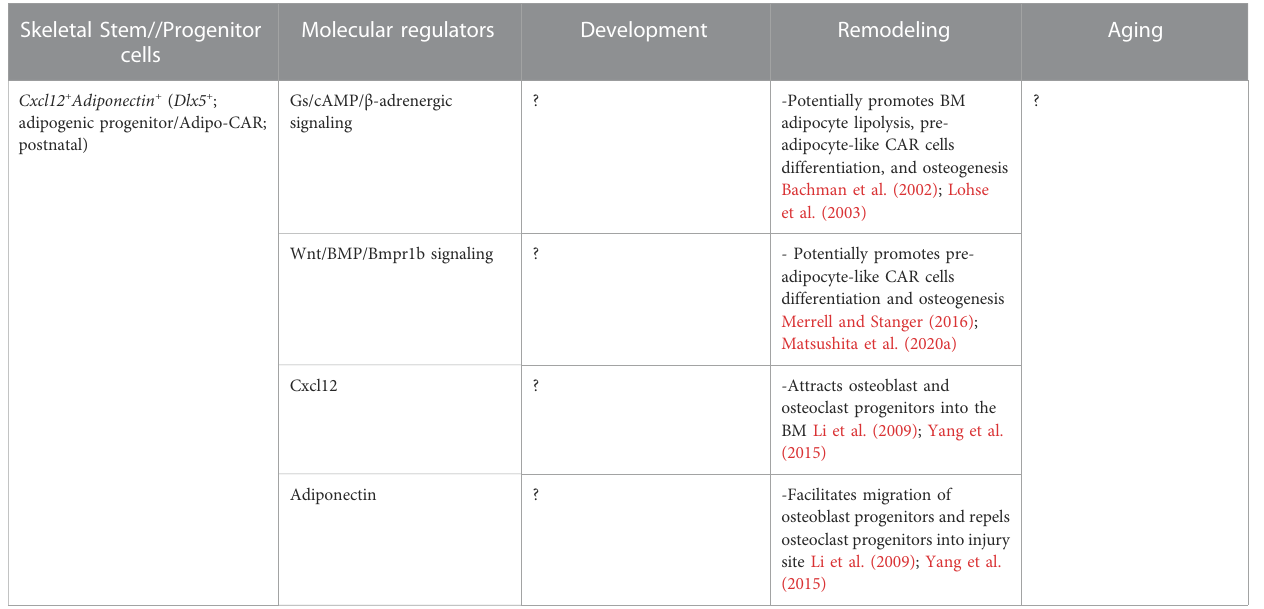
TABLE 1 ( Continued ) Summary of the regulations of distinct skeletal stem//progenitor cells (SSPCs) in different skeletal compartments during development, remodeling and